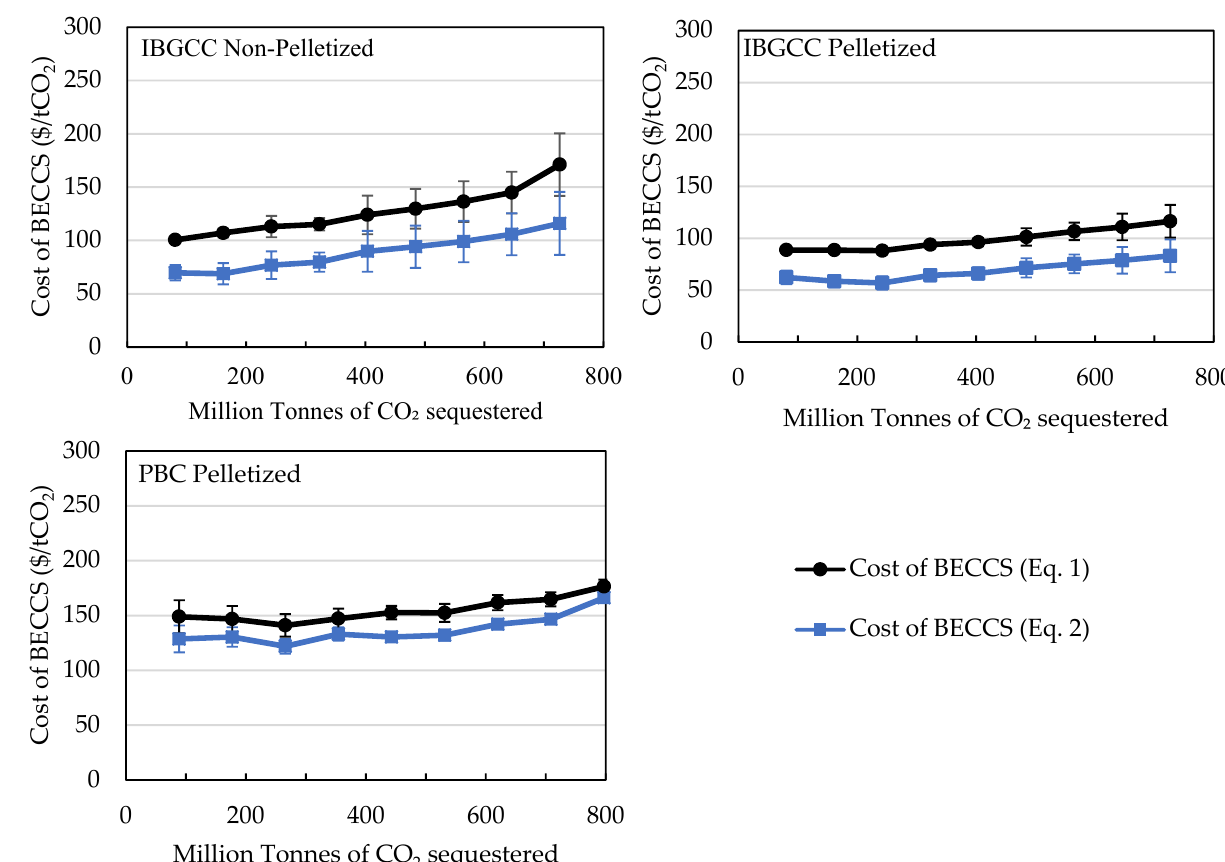
Figure 2. Scenario-average cost of BECCS (in $ per tonne of CO 2 captured) for the three BECCS scenarios. BECCS 1 (Equation (2)) represents the cost of BECCS alone while BECCS 2 (Equation (3)) represents the cost of BECCS with the wholesale of electricity [11].